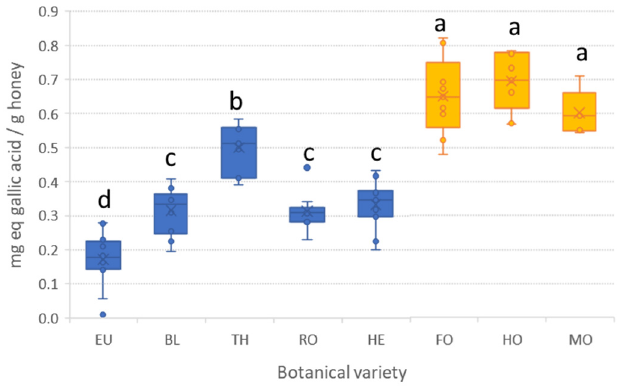
Figure 1. Boxplots with the total content of oxidizable species in honey samples according to the botanical origin. For botanical origin code refer to Table 1. Blue boxes correspond to blossom honeys, while orange ones correspond to honeydew honeys. The same letter indicates no significant differences ( α = 0.05).